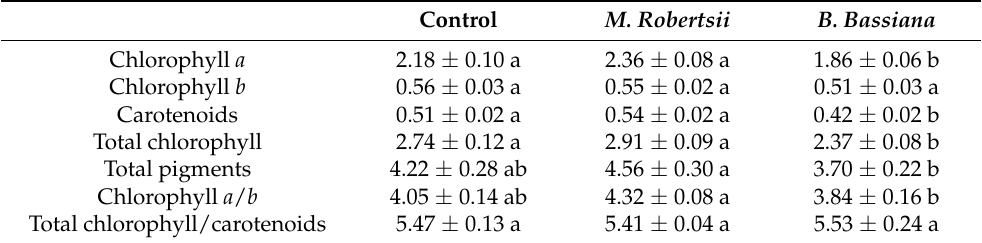
Table 3. Effect of EIPF on the content of photosynthetic pigments and pigment ratio in potato leaves. Presented values are means ± SE ( n = 25). The same letters in a raw indicate insignificant differences between treatments (pigment contents—Tukey HSD, p > 0.05; ratio of pigments—Dunn’s test, p > 0.05).